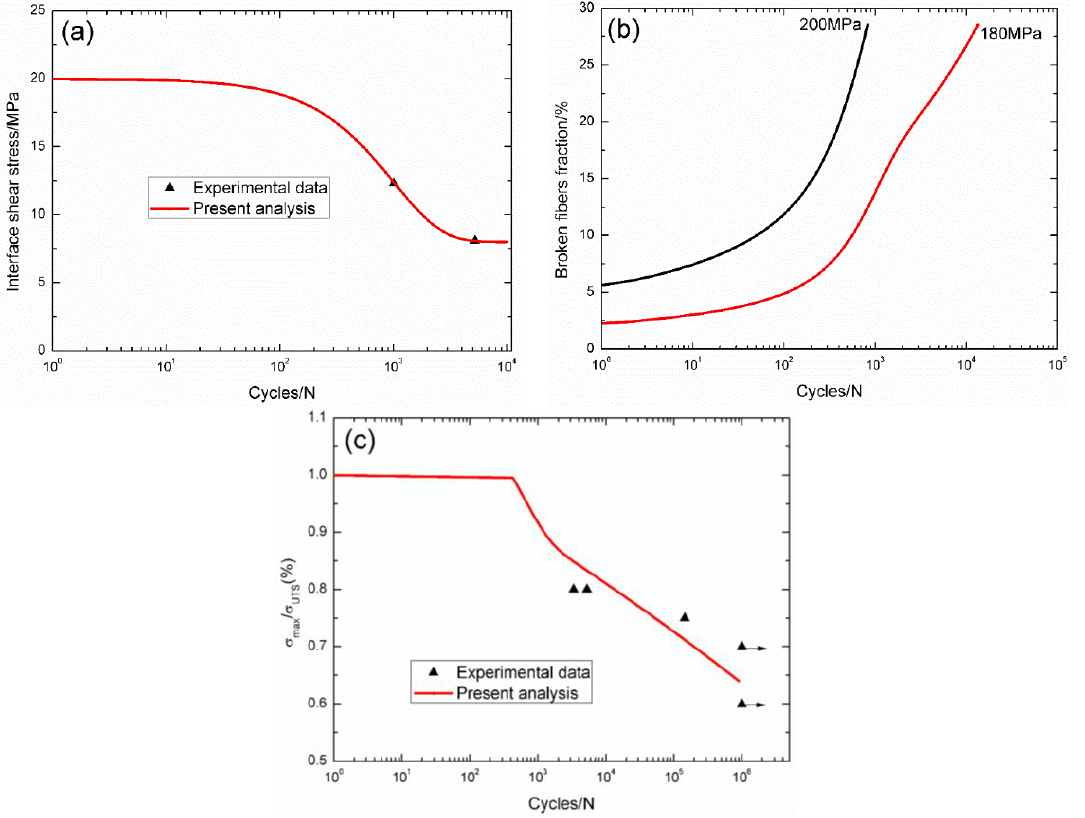
Figure 7. ( a ) The interface shear stress versus applied cycles; ( b ) the broken fibers fraction versus applied cycles; and ( c ) the fatigue life S–N curves of experimental data and theoretical analysis for 2.5D C/SiC composite at room temperature.